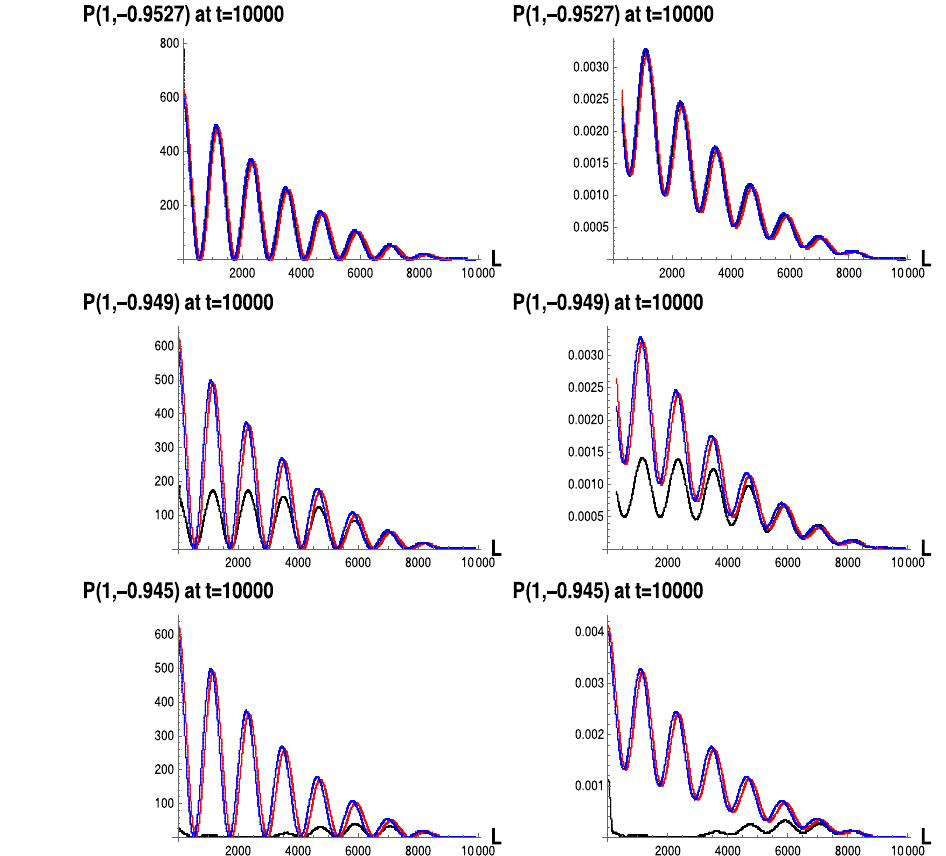
Fig. 1 The unnormalized probability density P ( k , l ) at k = 1 at various values of l , computed using the exact expression (3.7) (black curve) and also the approximations (3.20) (red curve) and (3.28) (blue curve). One can see that in the top panels, where l is near the on-shell value given in (3.35), the approximations are quite accurate, but they drop too slowly when l differs from the on-shell value in the lower panels. In the left we chose σ = σ = 0 . 1, on the right s d σ = σ = 0 . 015. Thus only on s d the right the source and detector sizes are of order the oscillation wavelength, and so the oscillation amplitude is